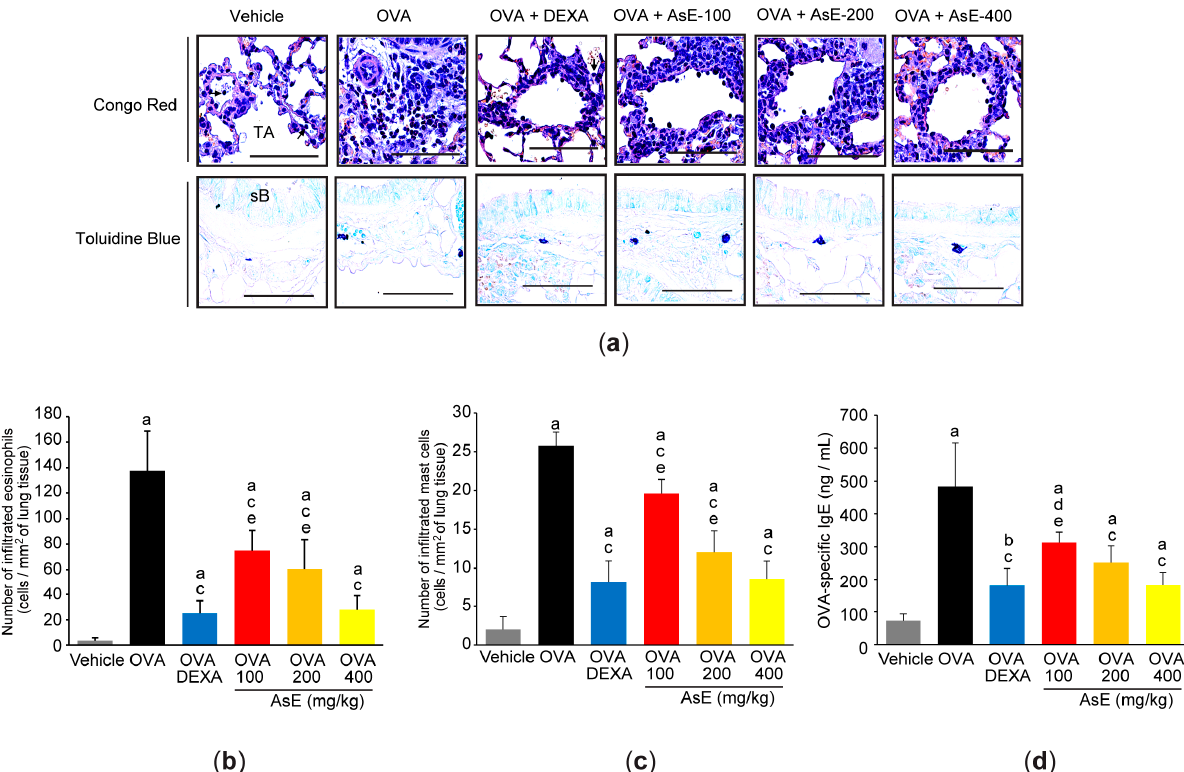
Figure 3. AsE inhibits the infiltration of inflammatory cells in the lungs. ( a ) Representative histological images of Congo-red- or toluidine-blue-stained lung tissue. Scale bars indicate 200 µ m. Numbers of infiltrated eosinophils ( b ) and mast cells ( c ) were counted in the tissue sections stained with Congo red and toluidine blue, respectively. ( d ) Level of OVA-specific IgE was measured in the serum. a p < 0.01, b p < 0.05 versus vehicle group; c p < 0.01, d p < 0.05 versus OVA group; e p < 0.01 versus OVA + DEXA group; IgE, immunoglobulin E.